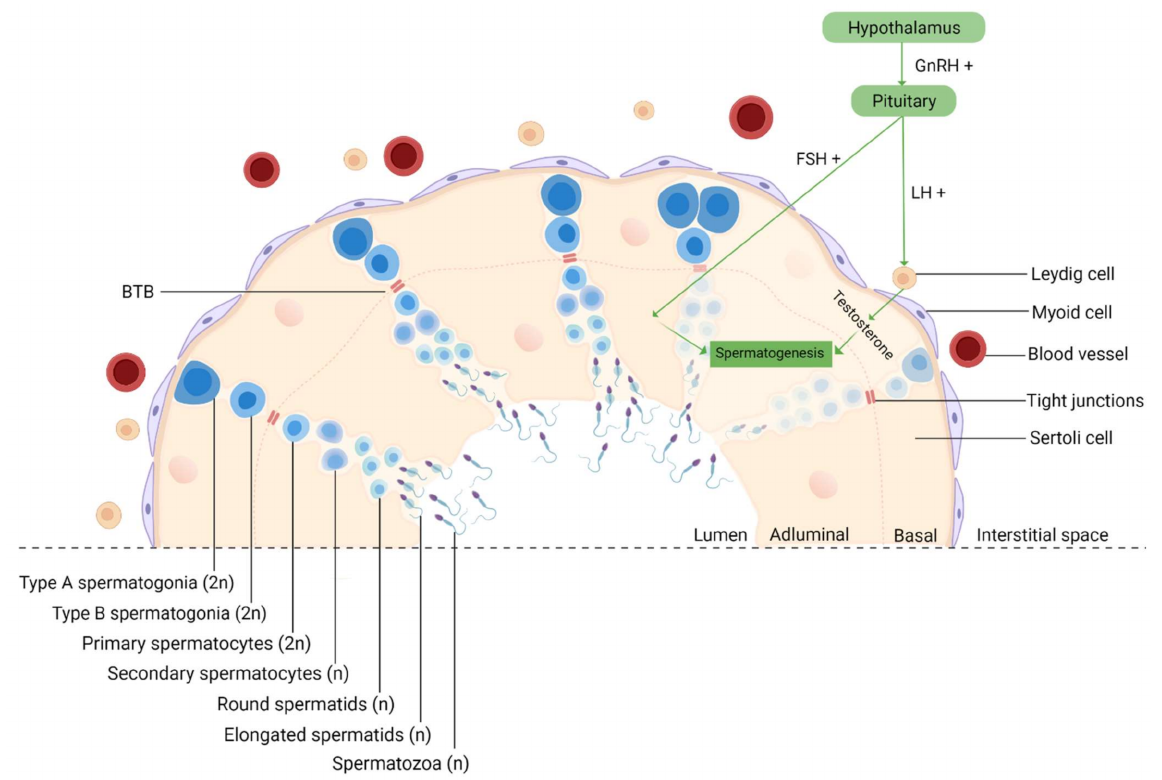
Figure 3. Schematic representation of spermatogenesis in the cross-section of a seminiferous tubule. Spermatogenesis is initiated at puberty by the hypothalamus, which produces GnRH, which, in turn, stimulates the release of FSH and LH at the reproductive tract. LH stimulates Leydig cells to produce testosterone and FSH stimulates Sertoli cells that provide support and nutrition for sperm survival, proliferation, and differentiation [102]. Sertoli cells then initiate the functional responses required for spermatogenesis. Spermatogenesis starts when type A spermatogonia (2n) commit to differentiating into type B spermatogonia. Then, through mitosis, B-spermatogonia (2n) give rise to primary spermatocytes (2n). The latter undergo a long meiotic phase that originates the secondary spermatocytes (n), which ends with spermatids (n) generation [103]. The round spermatids then go through substantial morphological changes during spermiogenesis originating highly specialized spermatozoa through the reorganization of the entire cell, where the nuclear envelope seems to be crucially involved [104,105]. The next event is spermiation, in which mature spermatids are released from the supporting Sertoli cells into the lumen of the seminiferous tubule, and the remainder of the spermatid cytoplasm, known as the residual body, is phagocytosed by the Sertoli cells [106]. However, at this stage, spermatozoa still lack motility. Immotile spermatozoa are then transported into the epididymis where the final steps of maturation occur [107]. GnRH, gonadotropin-releasing hormone; LH, luteinizing hormone; FSH, follicle-stimulating hormone; BTB, blood–testis-barrier; 2n, diploid cell; n, haploid cell, created with Biorender.com (accessed on 2 July